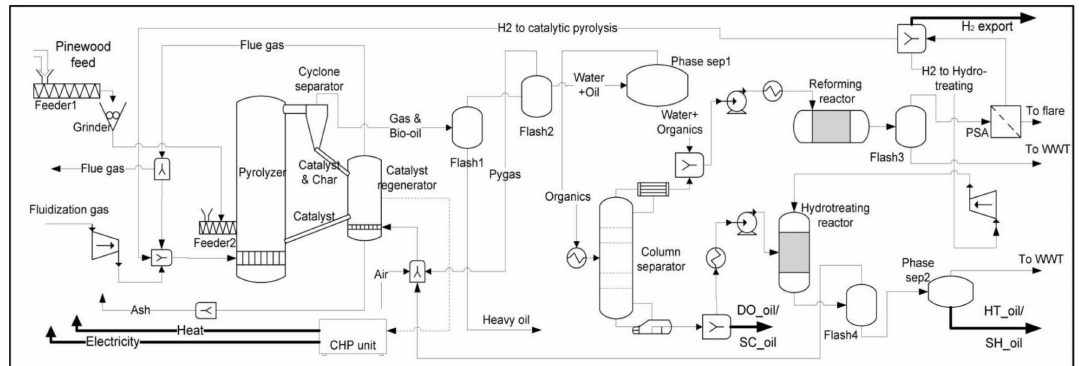
Figure 2. Process flow diagram for catalytic pyrolysis.